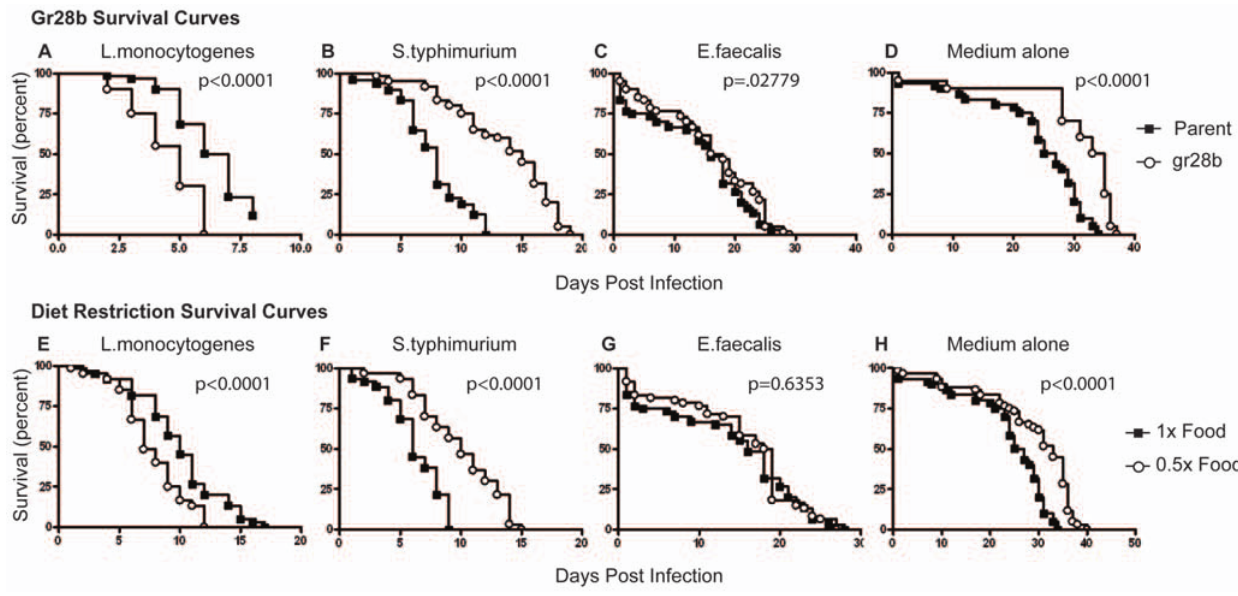
Figure 3. Effect of mutation of the gustatory receptor gr28b and diet restriction on sensitivity to infections. Isogenic wild-type and gr28b homozygous mutant flies were challenged with (A) L. monocytogenes ( p , 0.0001); (B) S. typhimurium ( p , 0.0001); (C) E. faecalis ( p =0.2779); or (D) medium alone ( p , 0.0001); and survival rates were measured and compared between flies given the two treatments. Wild-type flies fed on 1 6 and 0.5 6 diets, and were challenged with (E) L. monocytogenes ( p , 0.0001); (F) S. typhimurium ( p , 0.0001); (G) E. faecalis ( p =0.6053); or (H) medium alone ( p , 0.0001) and survival rates were measured. Significance was determined by log-rank test. Effects of gr28b mutations and diet restriction in unmanipulated flies on lifespan are shown in Figure S1.